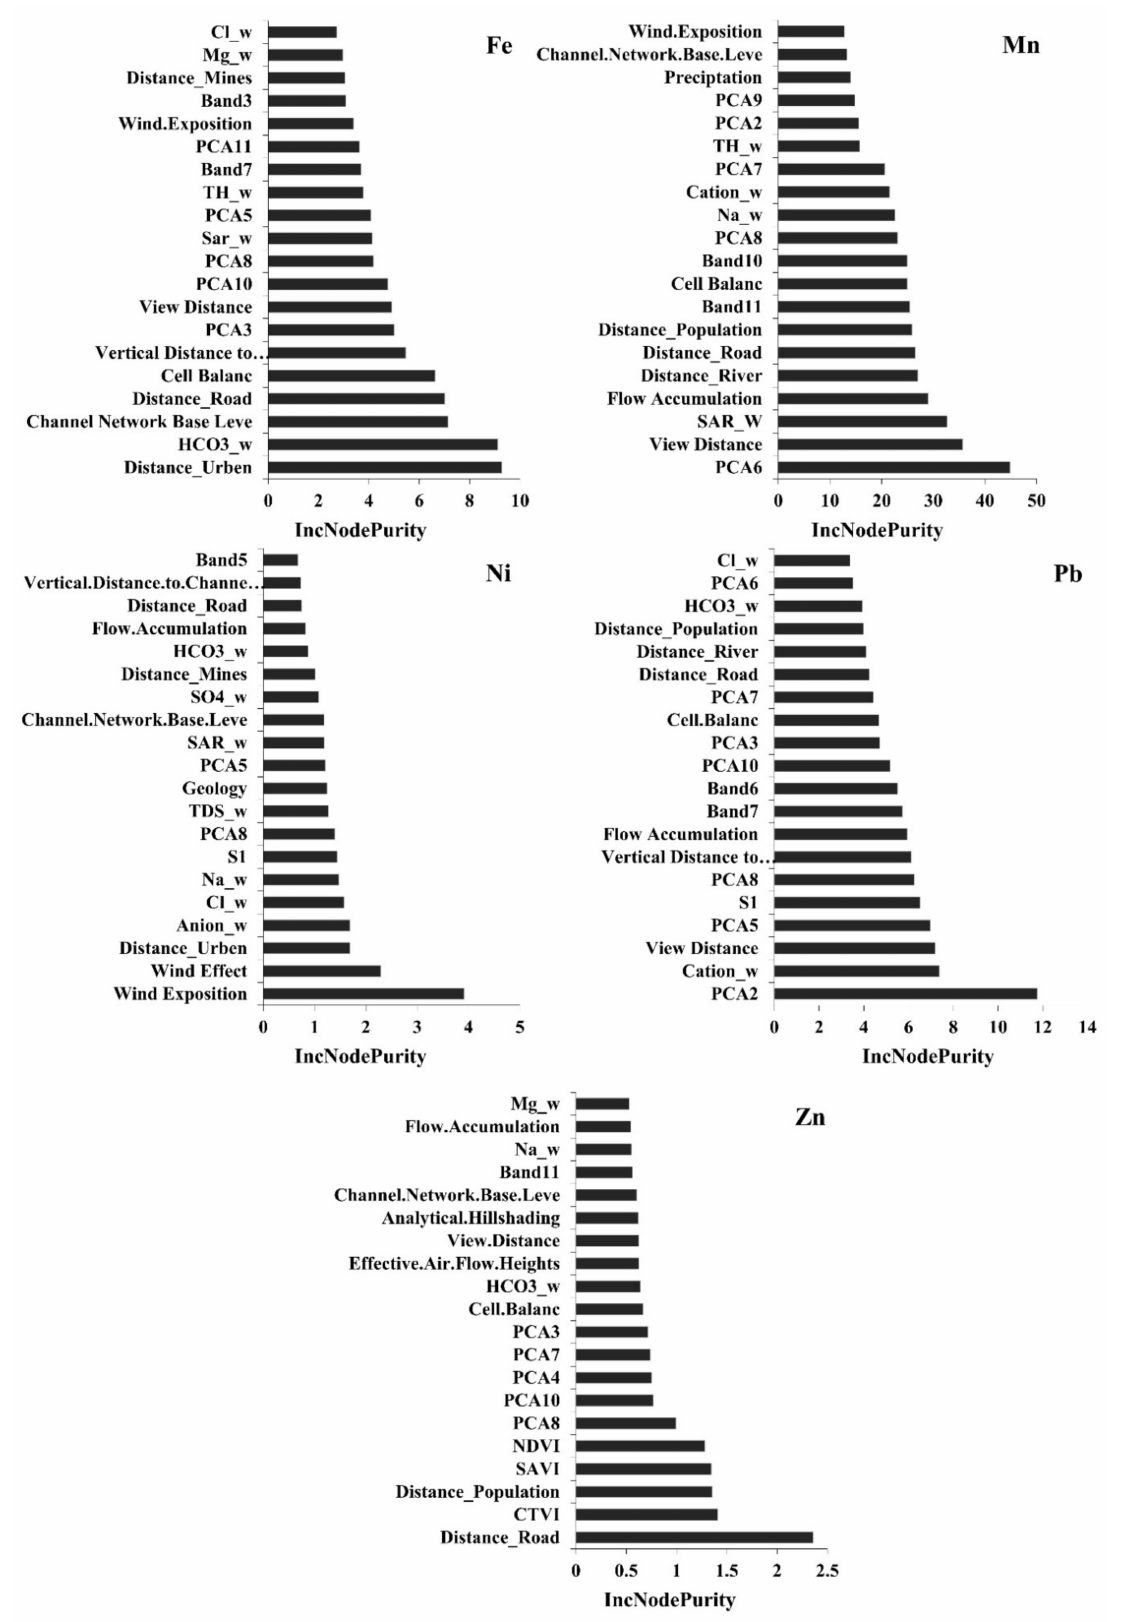
Figure 4. Covariate importance for predictions of heavy